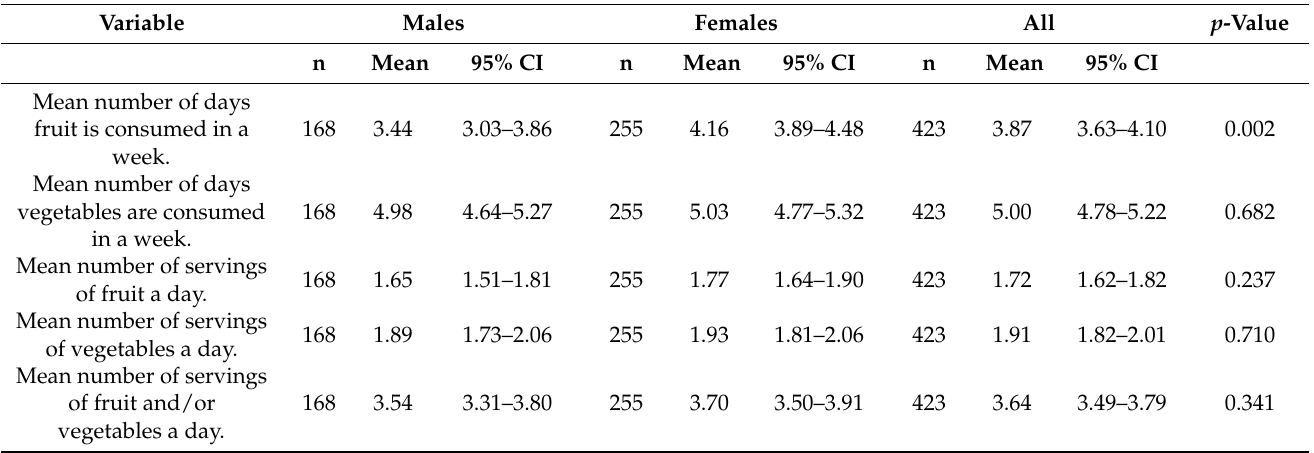
Table 3. Mean number of days and servings of fruit and vegetables consumed in a typical day and week.